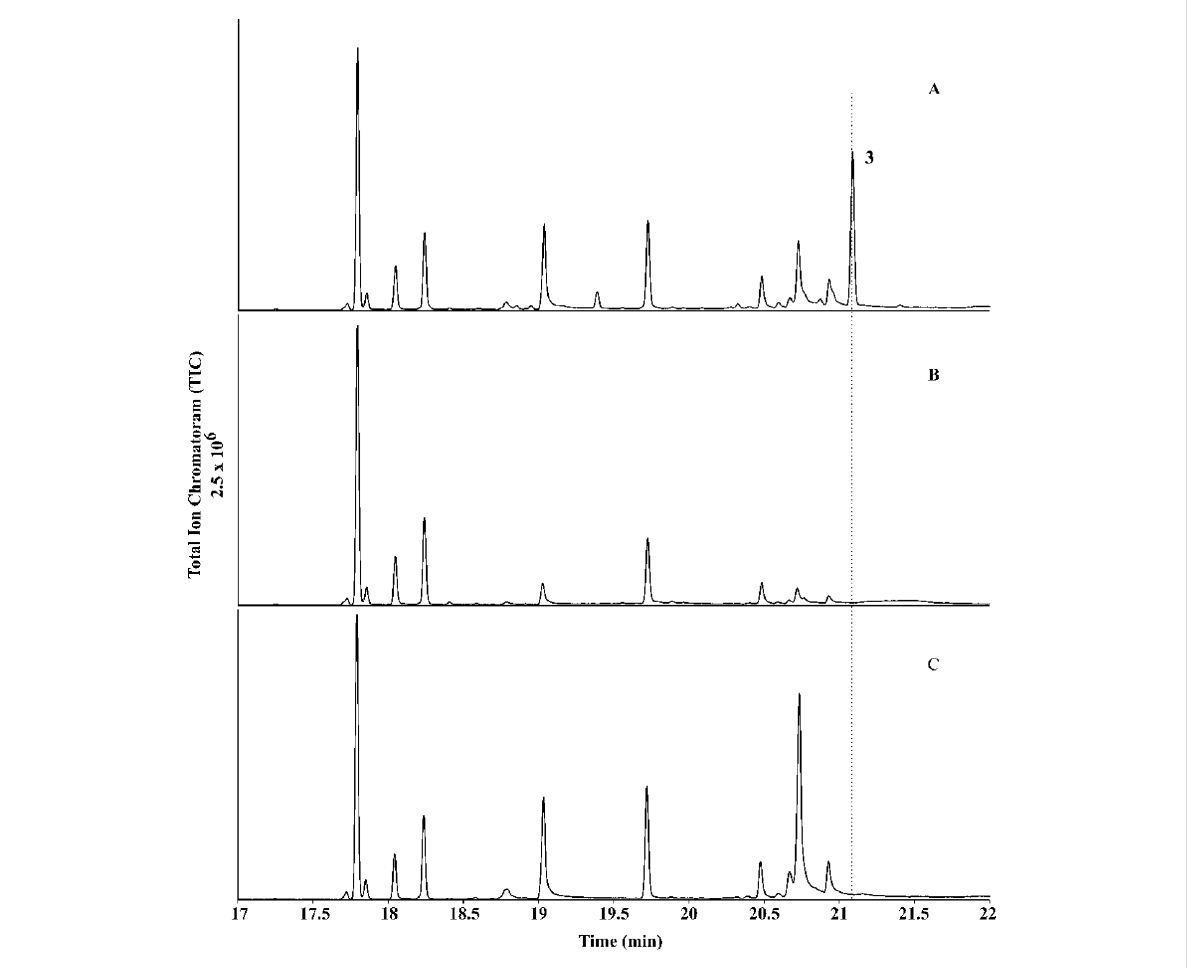
Figure 6: Transient expression of 18-hydroxydolabella-3,7-diene synthase (HdS) in Nicotiana benthamiana . Total ion chromatograms of GC–MS analyses of N. benthamiana leaf extracts. A) HdS-mit (HdS expressed with mitochondrial targeting signal) showing the production of 3 in planta, B) HdS (expression without targeting signal) and C) empty